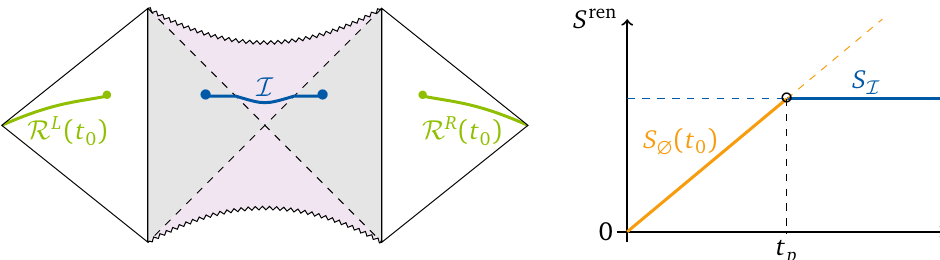
Figure 2: On the left is the two-sided thermal configuration of (II) featuring both the ) ∪ R R ( t ) and the island I which emerges at late times. t = t radiation region R L ( t 0 0 0 The right figure is a sketch of the (eternal) Page curve depicting (renormalized) en- tanglement entropy versus time—initially the time-dependent no-island entropy S ∅ is minimal, but it eventually exceeds the non-trivial island entropy S . This curve I can be obtained by computing (renormalized) areas in the (III)